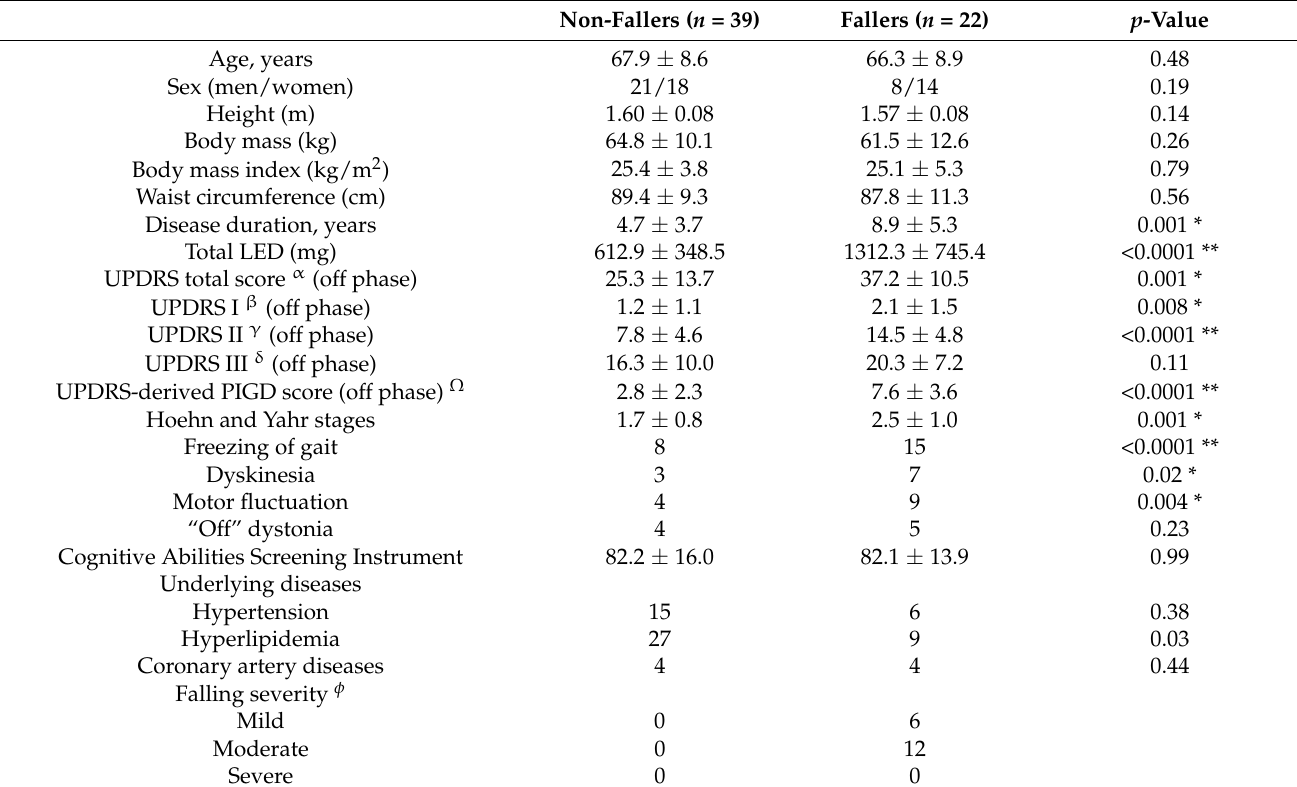
Table 1. Baseline characteristics of Parkinson’s